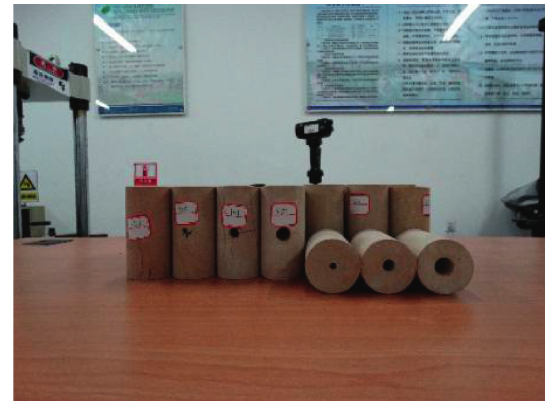
Figure 1: Samples with different hole positions and diameters. Table 1: Sizes and mass of rock samples with different hole positions and diameters. Sample